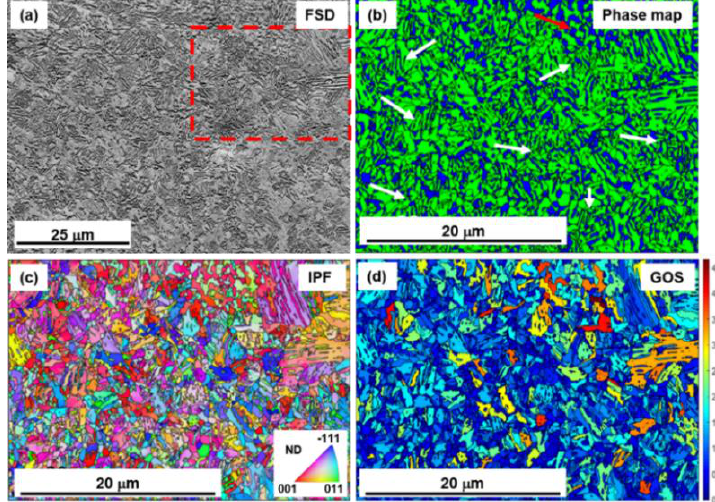
Figure 3. Electron backscatter di ff raction measurement of initial microstructure in AUS + ART annealed specimen, including ( a ) forescatter diode image, ( b ) phase distribution map, ( c ) inverse pole figure and ( d ) grain orientation spread image. The dashed box in ( a ) denotes the analyzed region for ( b – d ); red arrows in ( b ) indicates globular grains; white arrows marks the band-shaped lamellar grains.